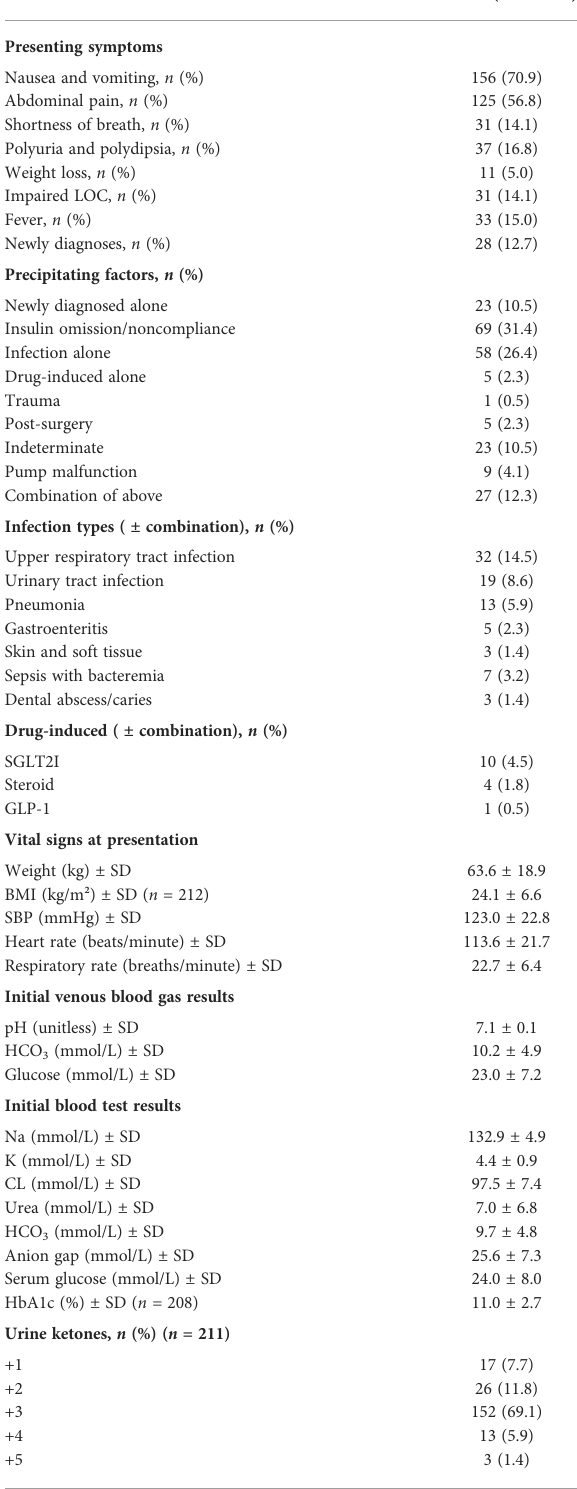
TABLE 2 Initial clinical and biochemical fi ndings in patients presenting with DKA.